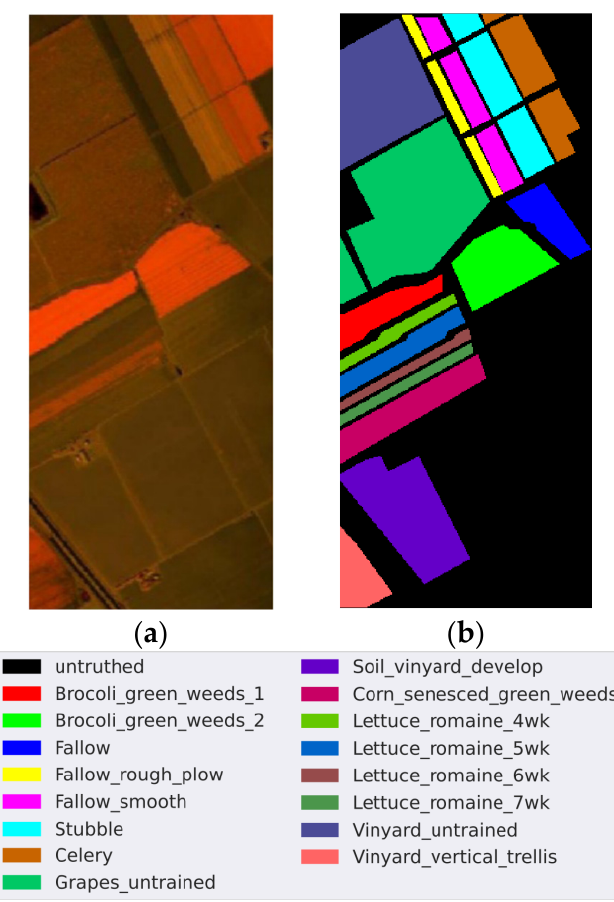
Figure 6. SA data set. ( a ) False-color image. ( b ) Ground-truth map. Table 3. Land cover classes and the numbers of samples in the SA data set.